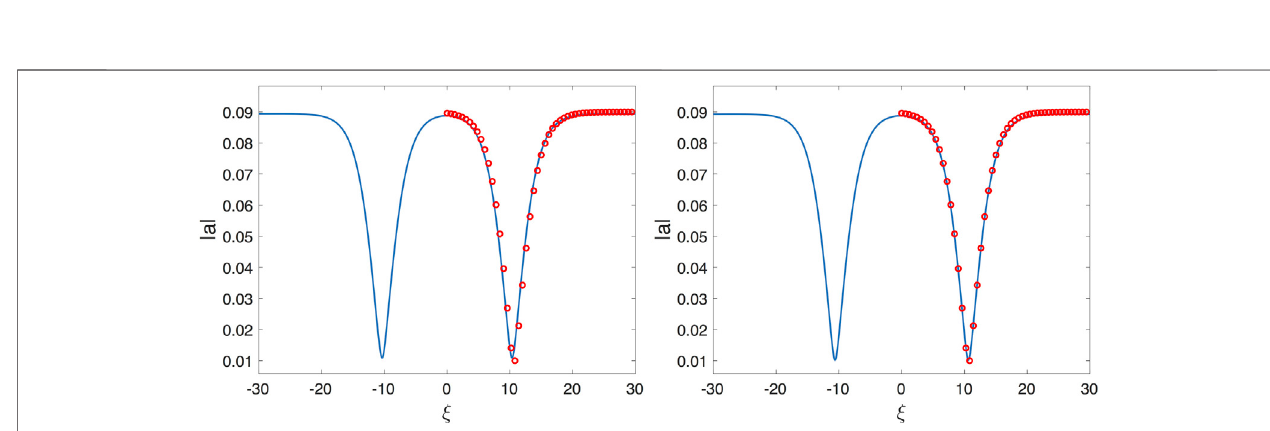
FIGURE4| Gray soliton profilesat t (cid:2) 867 T (left) and t (cid:2) 900 T (right) .The solidlines correspond tothenumericalsimulationwhereas thecircles correspondthe analytical solution of Eq. 4 for a 0 (cid:2) 0 . 09 and m (cid:2) π / 2 − 1 / 10.